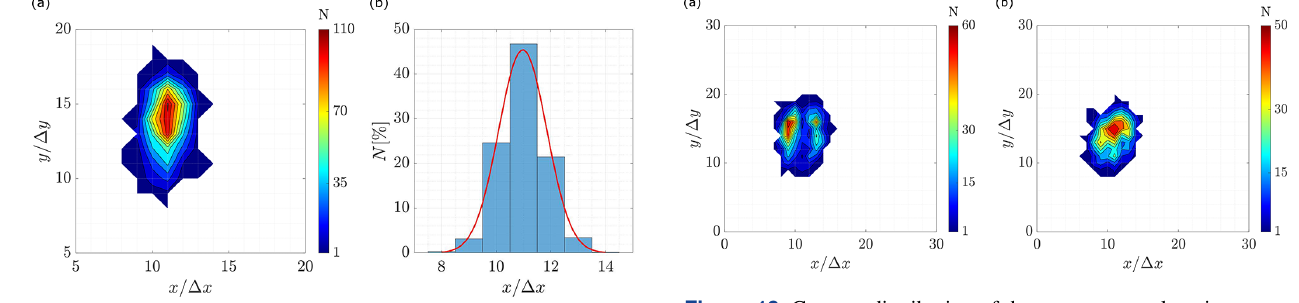
Figure 11. Jittering evaluation using Graftieaux’s VIM with 24- point scheme. (a) Contour distribution of the vortex center locations over the area of interest. (b) Probability distribution in the stream- wise direction.